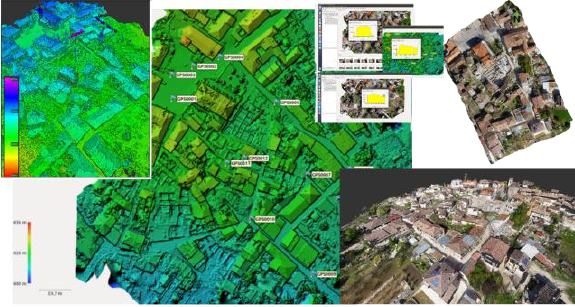
Figure 4. Point Cloud, DEM and orthomosaic of Villa Sant’Angelo (AQ)